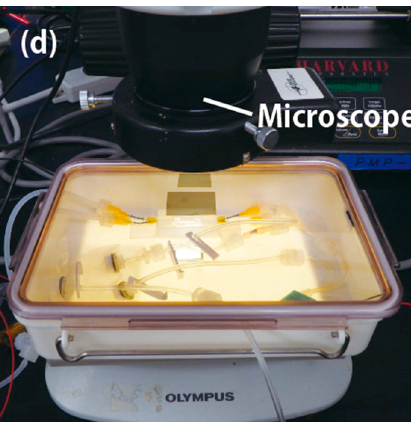
Figure 1. The crystallization device. ( a ) A conceptual diagram of the crystallization device; ( b ) overview of the device; ( c ) crystallization cell; ( d ) real-time observation system.